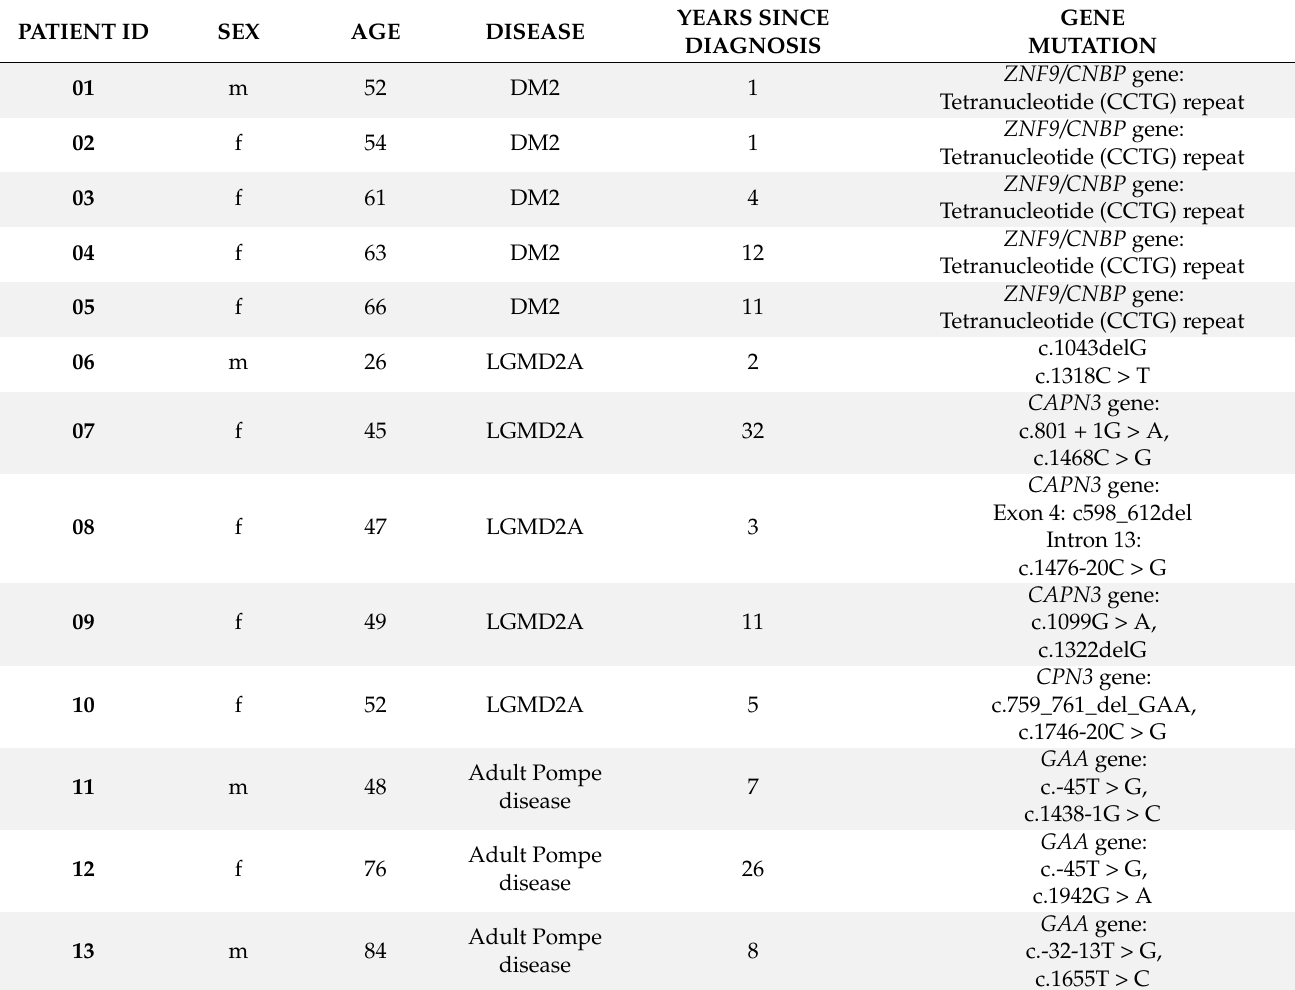
Table 2. Patient characteristics for patients with myotonic dystrophy type 2 (DM2), limb girdle muscular dystrophy type 2A (LGMD2A), and adult Pompe